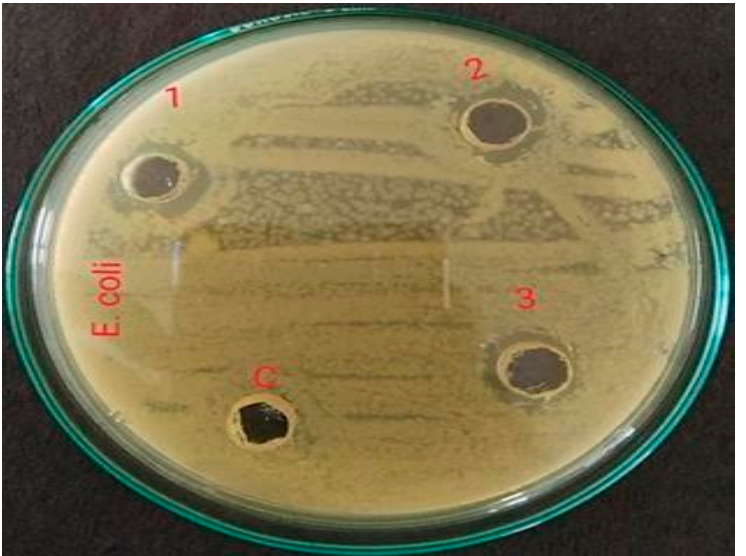
Figure 2. Zone of inhibition of Vigna radiata extract toward Escherichia coli ( 1 ) 13.2 mm, ( 2 ) 13.1 mm, ( 3 ) 13.1 mm and ( c ) control.